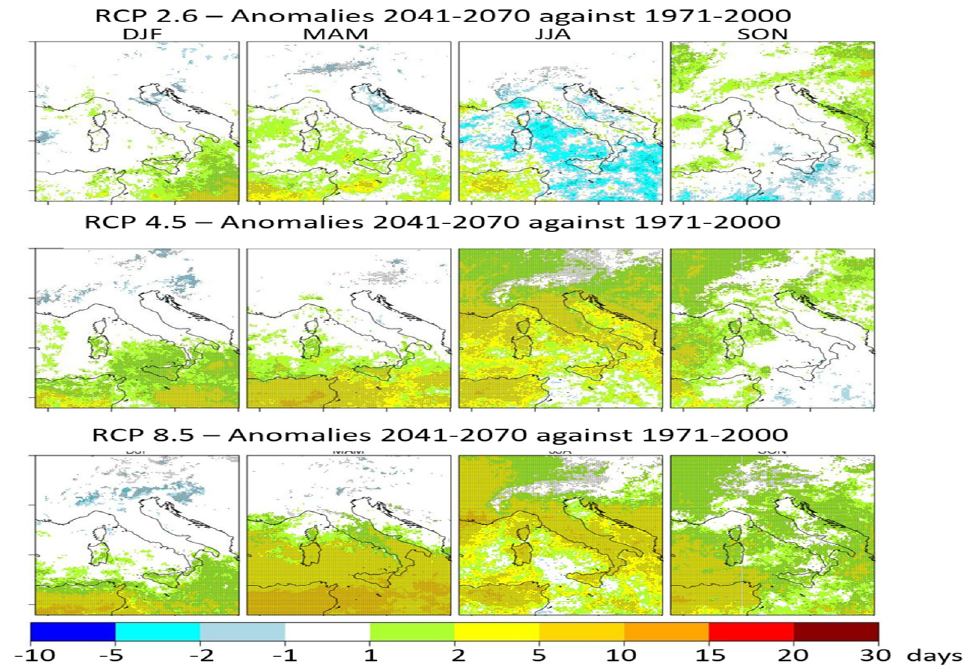
Figure 11. As Figure 10, but for the future scenario 2041–2070.